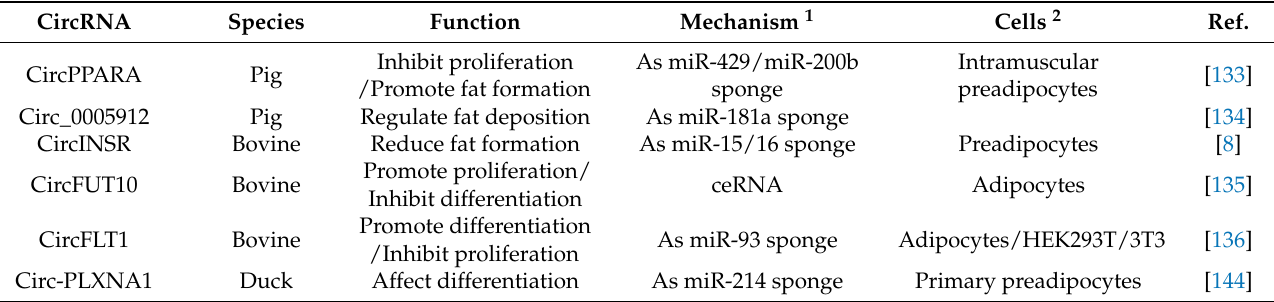
Table 2. Summary of circRNAs and their functions in fat